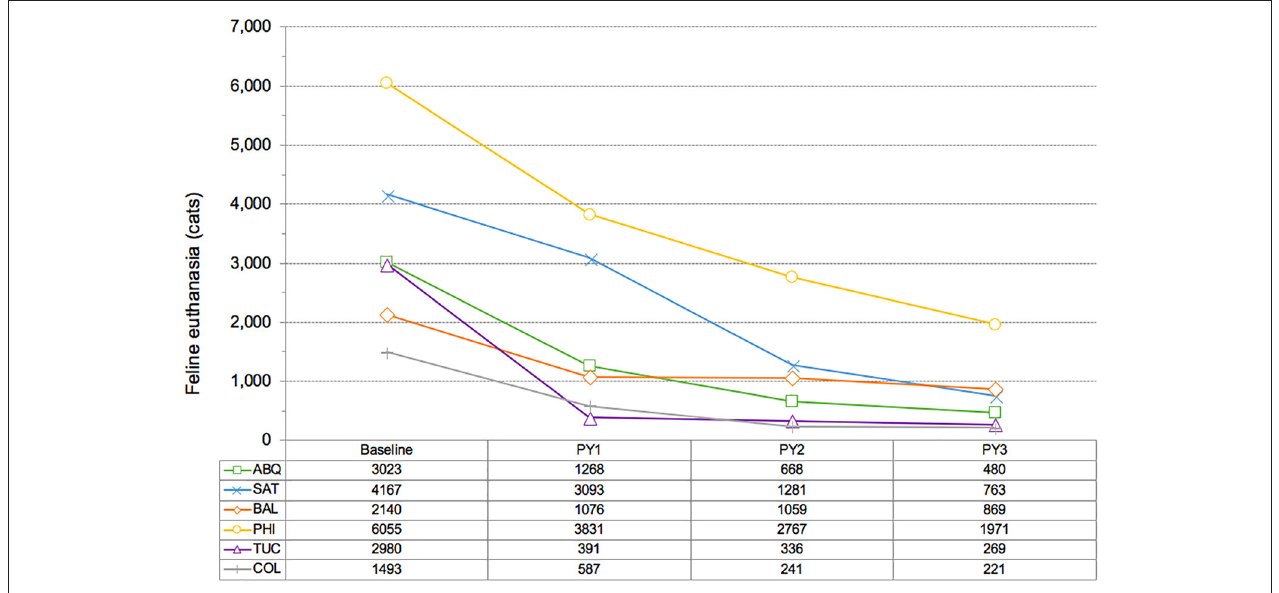
FIGURE 3 | Changes in feline euthanasia at six CCP shelters, comparison of baseline level to euthanasia during each of three program years